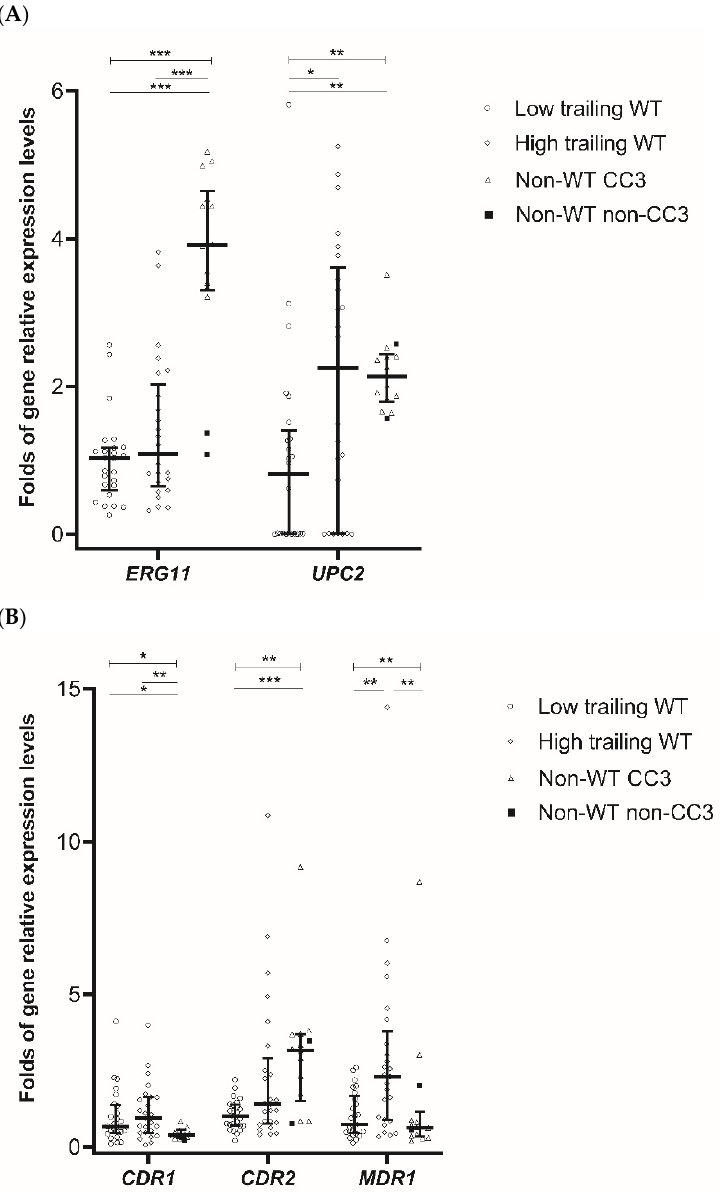
Figure 2. Expression levels of genes encoding the azole target or its transcription factor, ERG11 and UPC2 ( A ), and genes encoding efflux pumps, CDR1 , CDR2 , and MDR1 ( B ) of low and high trailing WT, and non-WT C. tropicalis isolates. Horizontal lines and error bars indicate medians and interquartile, respectively. Asterisks indicate statistical significance (*: p < 0.05; **: p < 0.01; ***: p < 0.001).